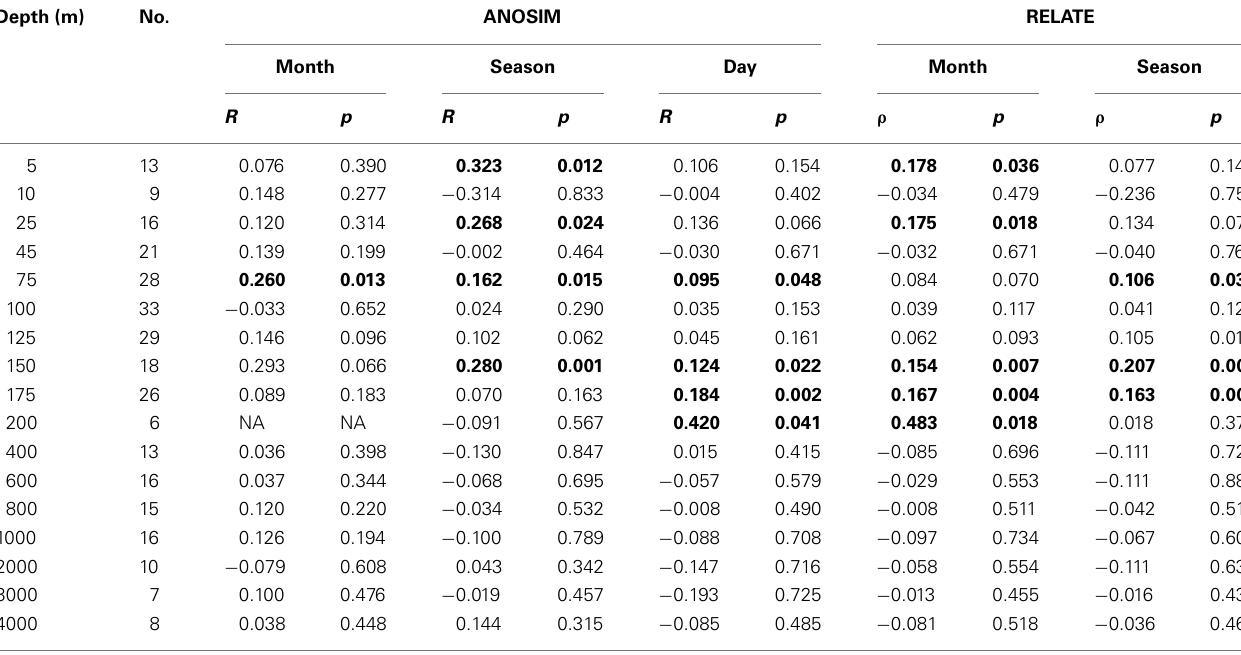
Table 2 | Statistical analyses of temporal patterns in bacterioplankton community structure at StationALOHA. Depth